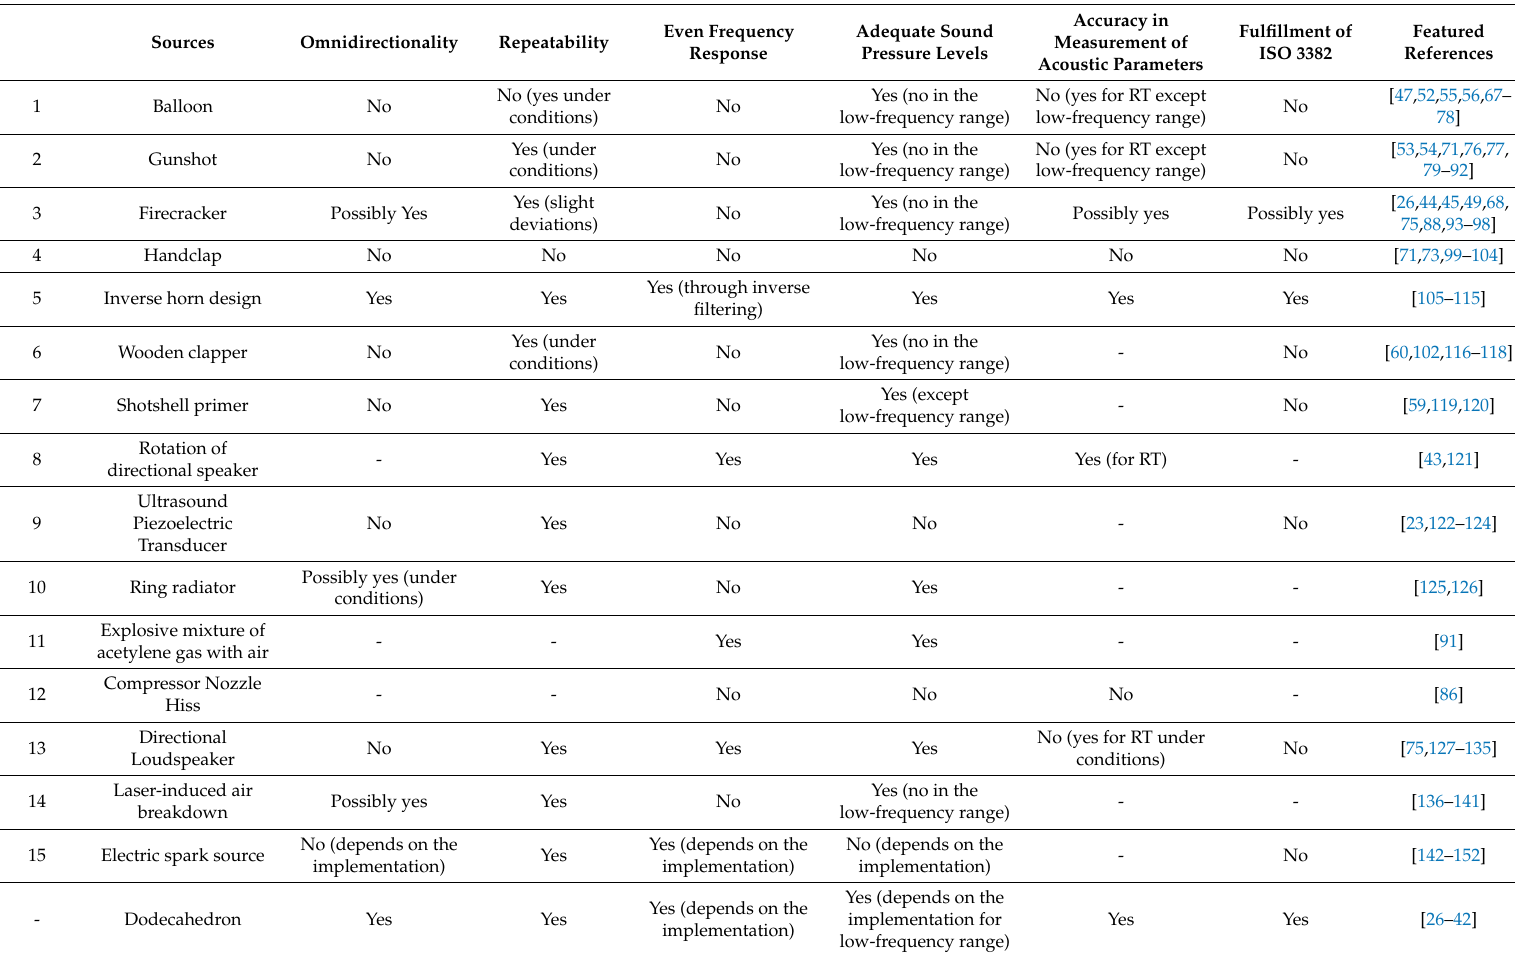
Table 5. Features of acoustic